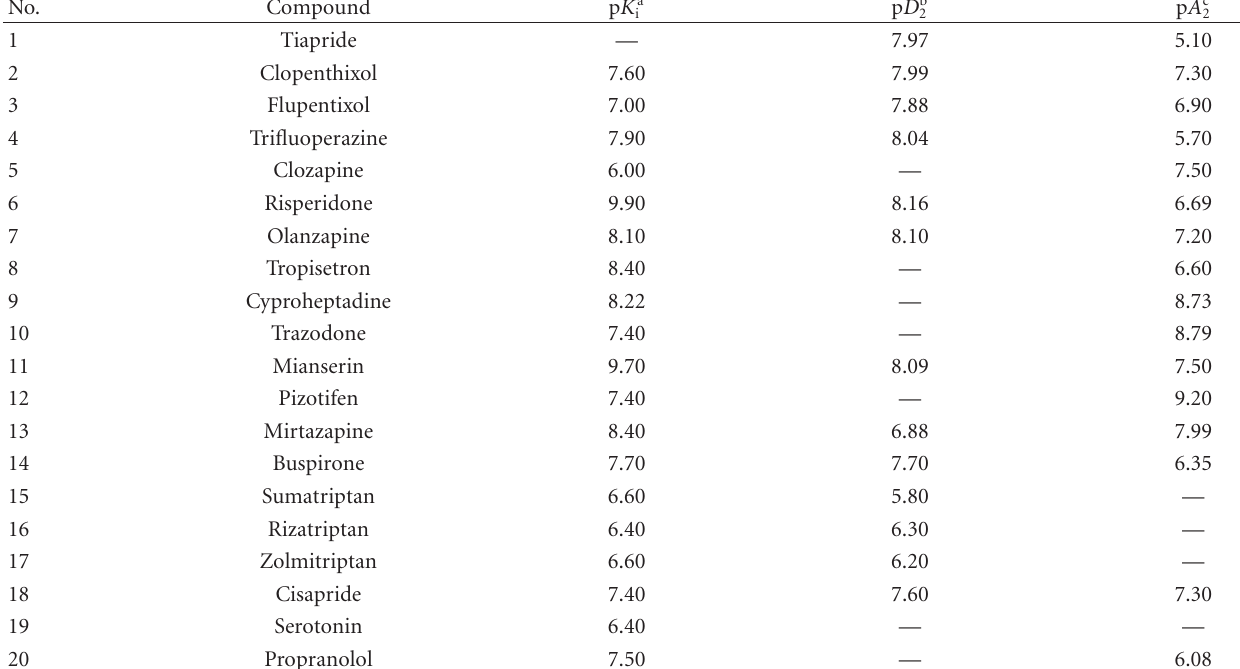
Table 1: Known biological activity for compounds 1–20 .